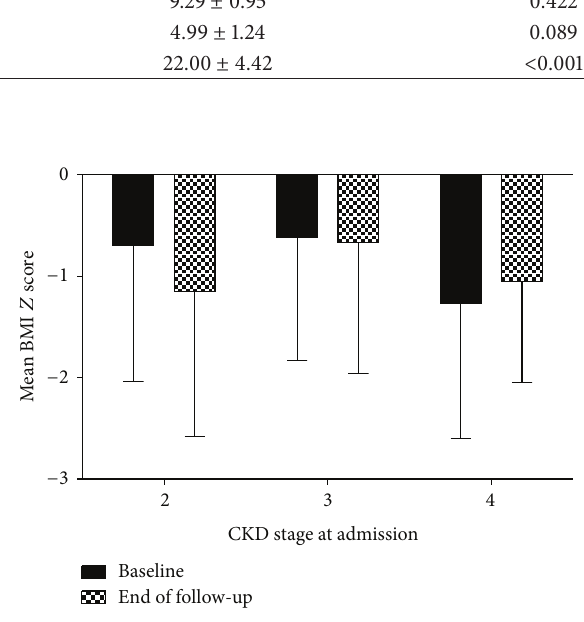
Figure 3: Mean values of body mass index (BMI) 𝑍 score at admission (baseline) and at last follow-up visit (end of follow-up) according to chronic kidney disease (CKD) stage at